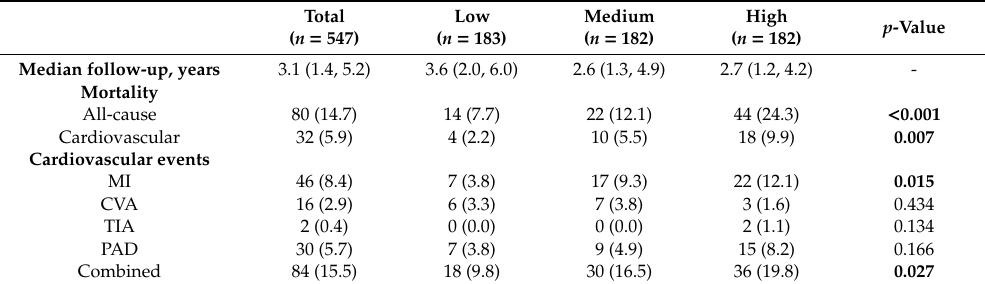
Figure 2. Kaplan-Meier curve for cumulative overall survival for the low aorto-iliac calcium score (CaScore tertile), the medium CaScore tertile, and the high CaScore tertile. The overall survival at the median follow-up time was 94.9% (95% CI 91.5–98.5) in the low, 90.5% (95% CI 85.4–95.9) in the medium, and 71.0% (95% CI 62.7–80.3) in the high CaScore tertile. Table 3. Number (%) of cardiovascular events and